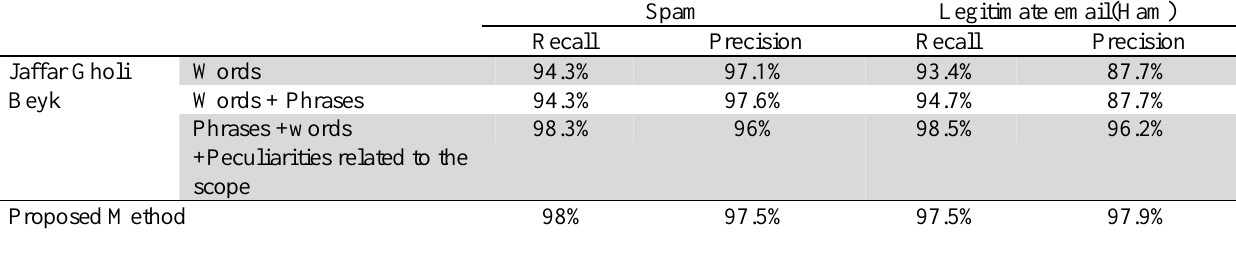
Comparing Precision and Recall of proposed method using the method by Jaffar Gholi Beyk, (2012) Spam Legitimate email(Ham) Recall Precision Recall Precision